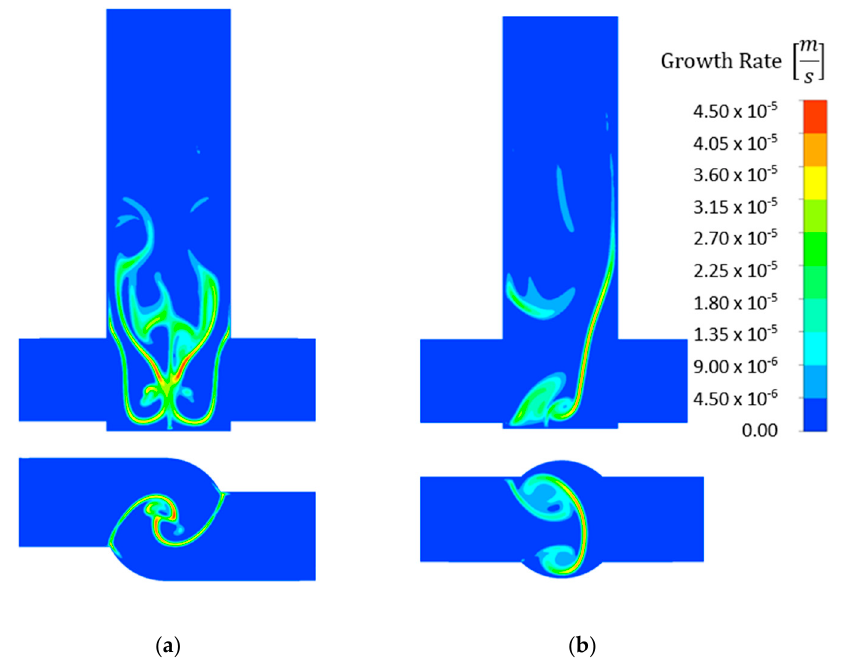
Figure 12. Comparison of growth rate [m s − 1 ] contour plots for 0.6 mol/dm 3 AS and 20 mL/min flow rate in ( a ) V- and ( b ) T-type reactors.